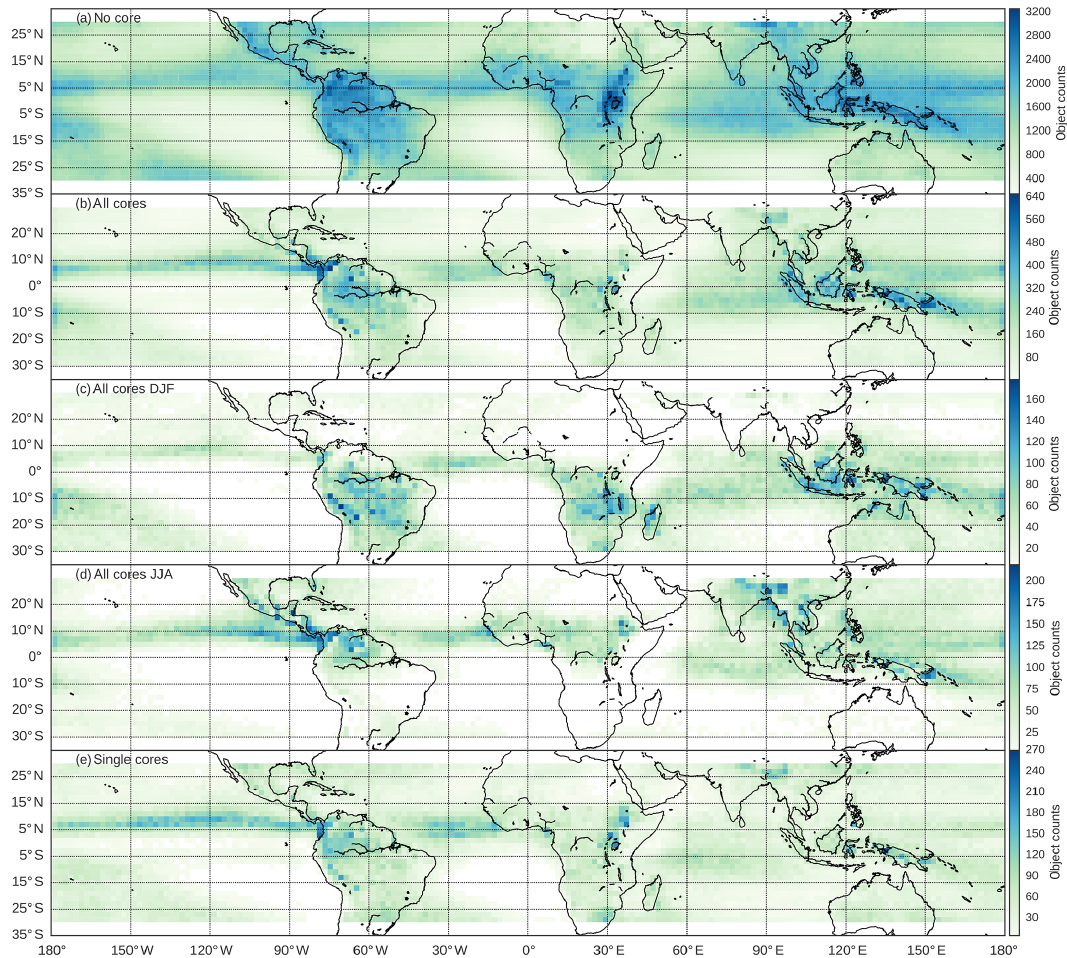
Figure 5. Geographic maps of (a) isolated cirrus systems and (b) all convective cores, as well as separately for (c) boreal winter, (d) boreal summer and (e) single-core convective systems for the 2003–2015 period of the LMD AIRS cloud climatology (AIRS data,